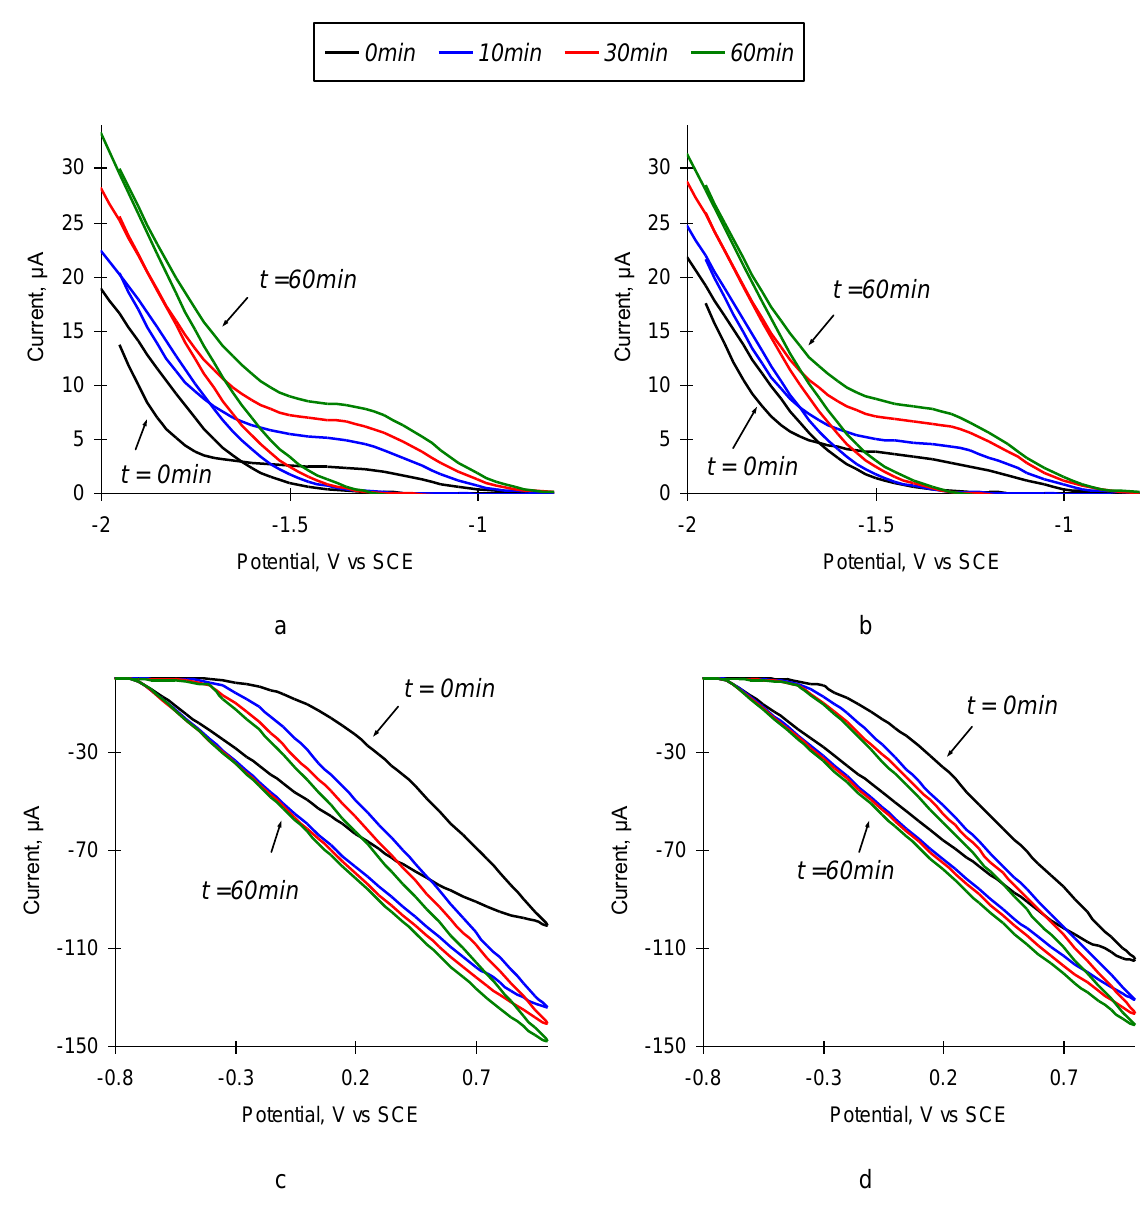
Figure 2. Cyclic voltammogramms of SEB immunosensors in 0.3% NaCl solution without toxin (a,c) and with addition of 10 μg/mL SEB (b,d) as a function of time (0 min, 10 min, 30 min, and 60